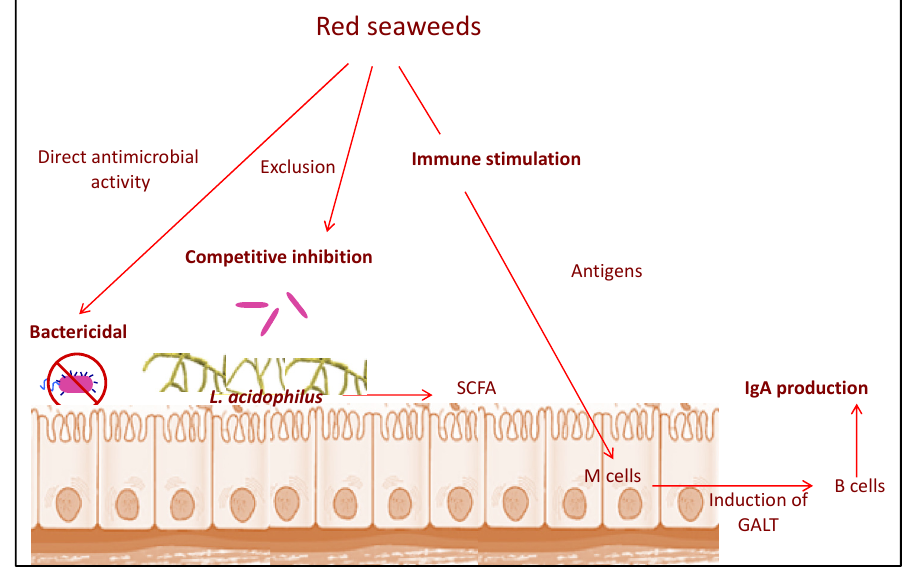
Figure 4. Dietary inclusion of red seaweeds in laying hen diets was observed to suppress the negative effect of SE on laying hen growth and performance. Various mechanisms included direct inhibition (bactericidal) of bacterial colonization of feces and ceca, competitive exclusion (i.e., reduction of E. coli titers) by beneficial bacteria such as Lactobacillus acidophilus and immune stimulation. SCFA: short chain fatty acid; GALT: gut-associated lymphoid tissue (Original figure by G.K.).